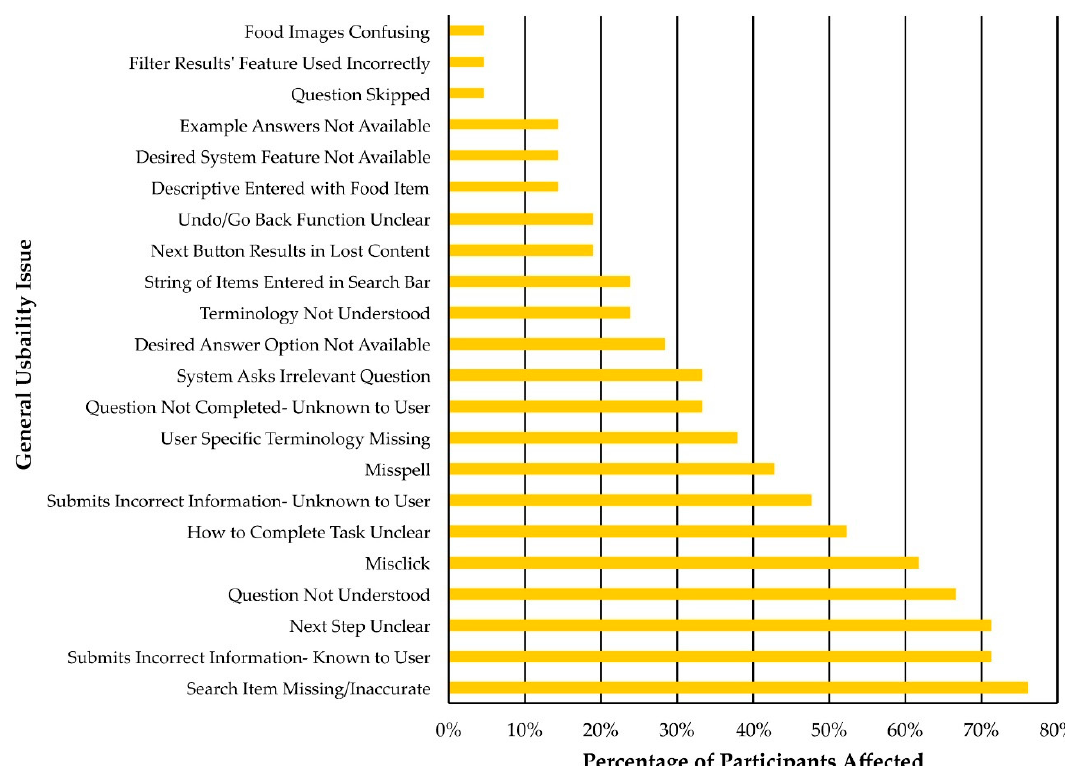
Figure 6. Percentage (%) of participants in the semi-moderated ( n = 11) and moderated ( n = 10) groups that were observed being affected by each general usability issue at least once.